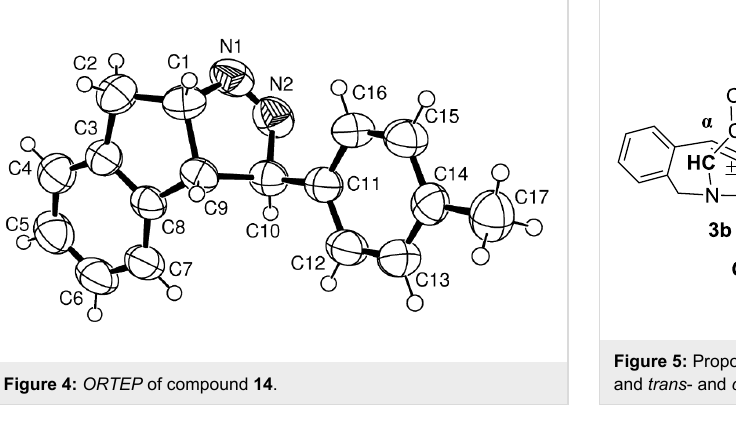
Figure 4: ORTEP of compound 14 .